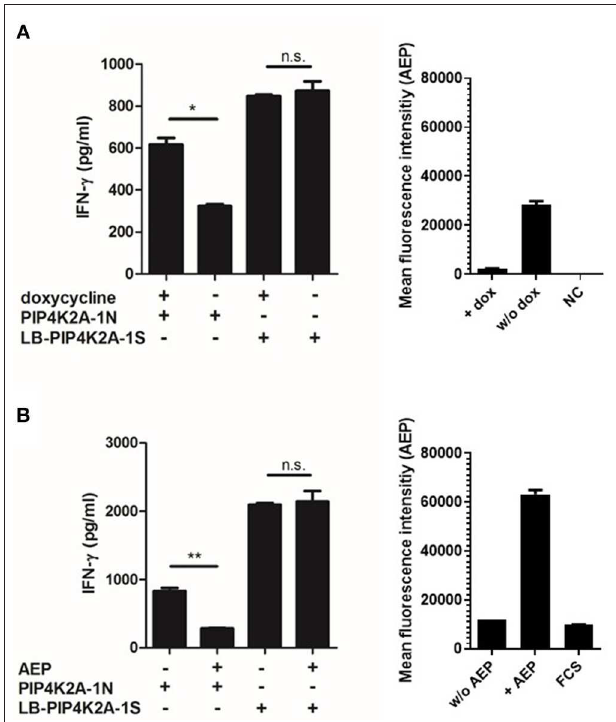
FIGURE 3 | Recognition of endogenously expressed PIP4K2A-1N donor variant correlates with activity of asparagine endopeptidase AEP. (A) SD1 cells expressing a tet-off vector system with AEP were retrovirally transduced with full-length genes encoding the LB-PIP4K2A-1S patient variant or PIP4K2A-1N donor variant and tested for T-cell recognition with and without prior doxycyclin (dox) treatment (left). Enzyme activity with and without doxycyclin treatment has been measured in cellular lysates (right). NC, negative control. (B) T-cell recognition of MJS retrovirally transduced with full-length genes encoding LB-PIP4K2A-1S patient variant or PIP4K2A-1N donor variant with or without additional transduction of AEP (LGMN). T-cell recognition has been tested in IFN- γ ELISA (left). Enzyme activity of AEP has been measured in transduced cell lines and fetal calf serum (FCS) as negative control (right). * P < 0.05; ** P < 0.01 (unpaired t -test). One representative of three independent experiments is